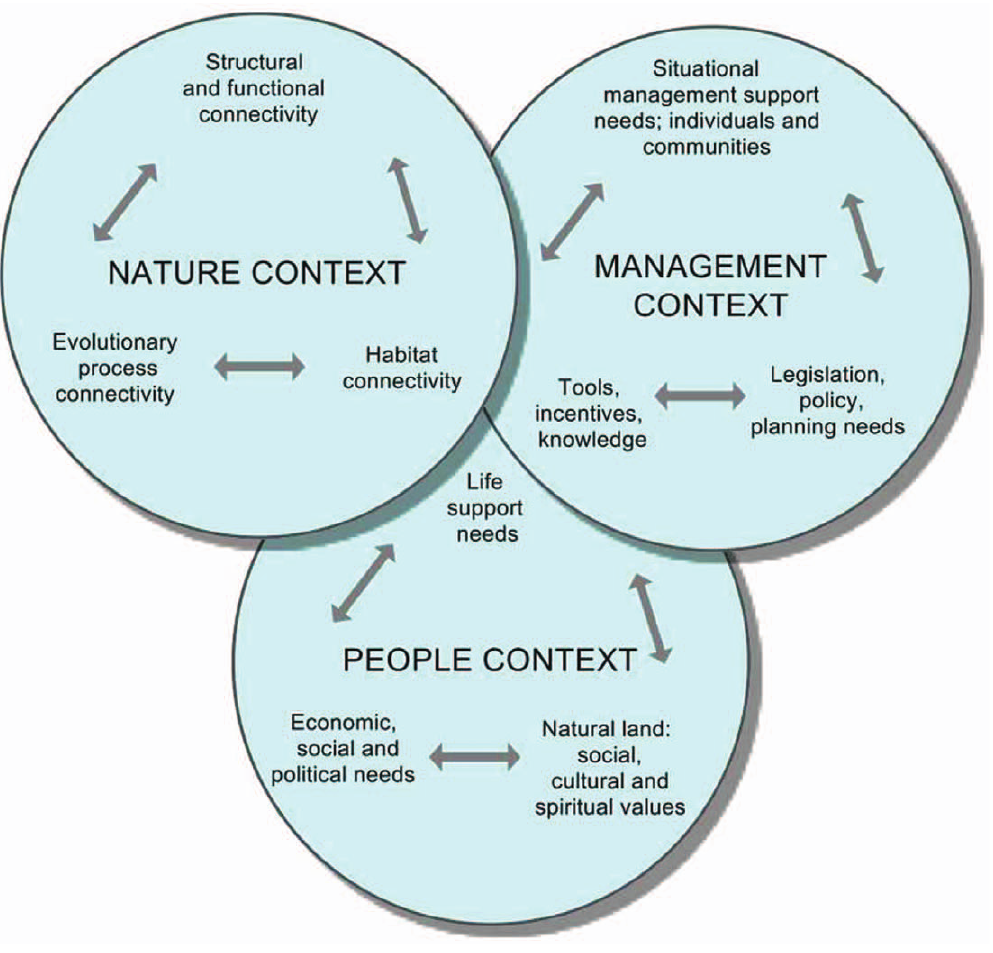
Figure 2. The three inter-related context areas of connectivity conservation adapted from Worboys et al. (2010). Every context area consists of three different sub-topics which interact with each other.